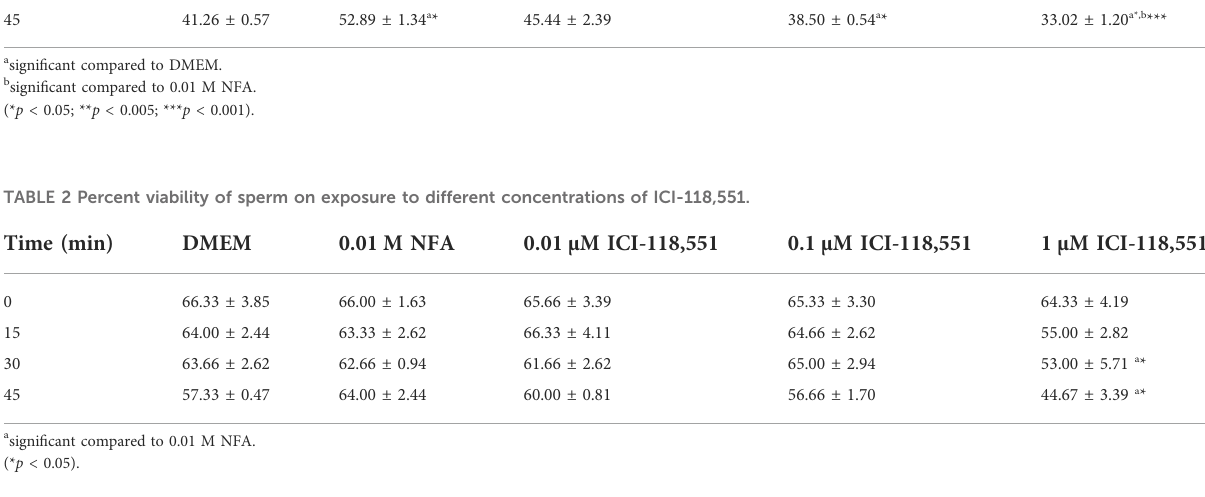
a signi fi cant compared to DMEM. b signi fi cant compared to 0.01 M NFA.